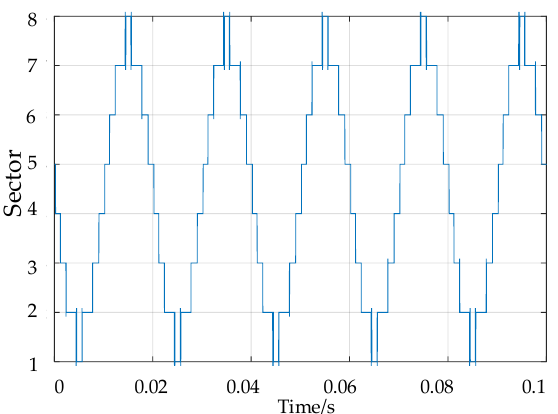
Figure 5. Sector judgement of rectifier during steady - state operation.